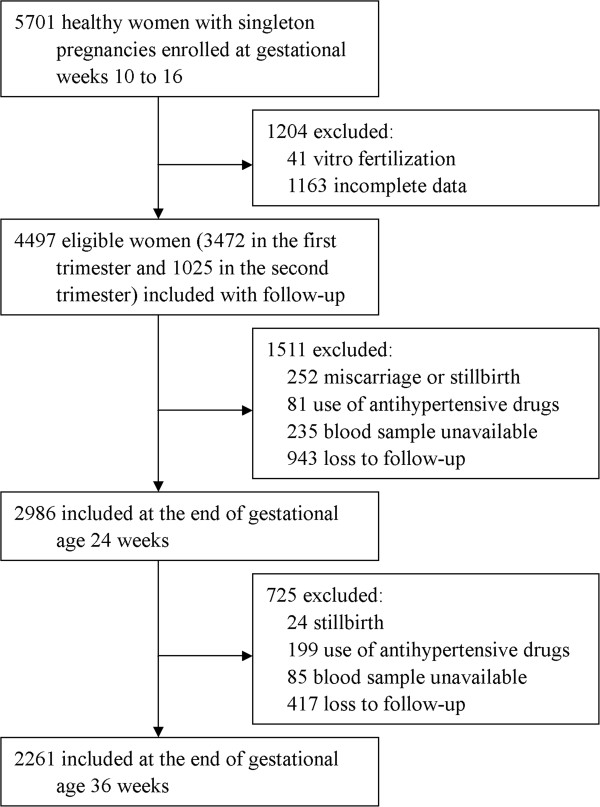
Flow diagram of study participants throughout pregnancy. 3472, 2986, and 2261 at each time point represent the number of women with complete data including body mass index (BMI), blood pressure, and blood samples as well as basic characteristics in the first, second and third trimesters, respectively.